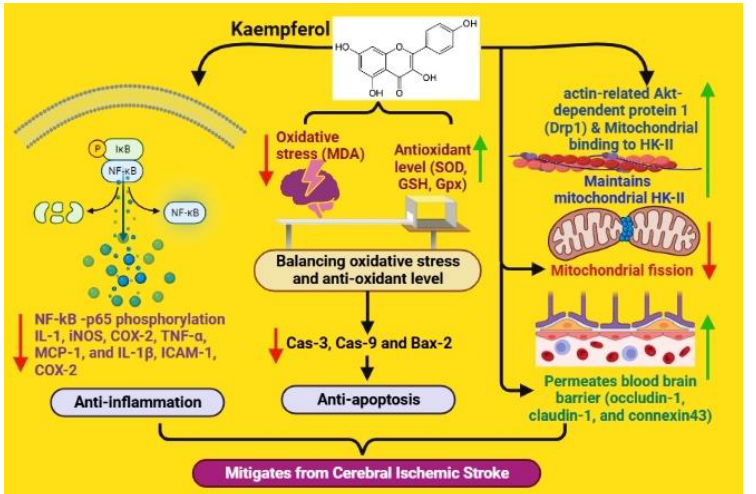
Figure 4. Effects of kaempferol on ischemic stroke (image created using biorender.com (accessed on 21 October